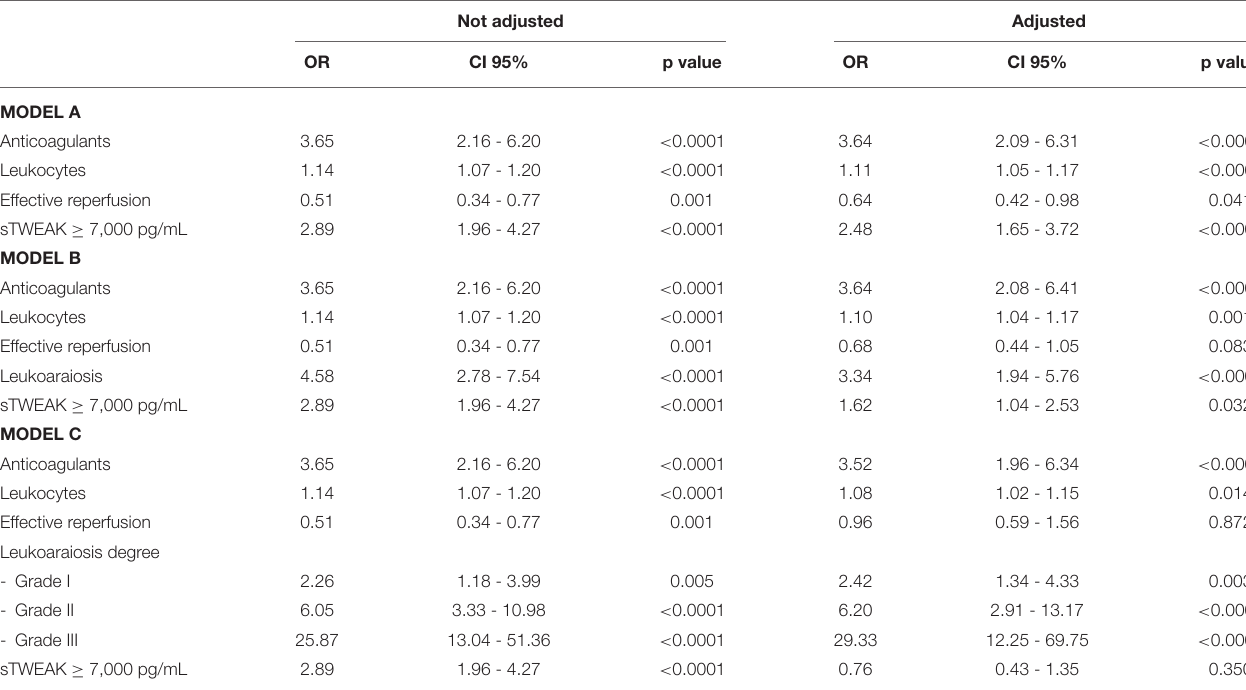
TABLE 4 | Multivariate analysis including biomarkers, leukoaraiosis and leukoaraiosis degree. Dependent variable: Recurrence. Not adjusted Adjusted OR CI 95% p value OR CI 95% p